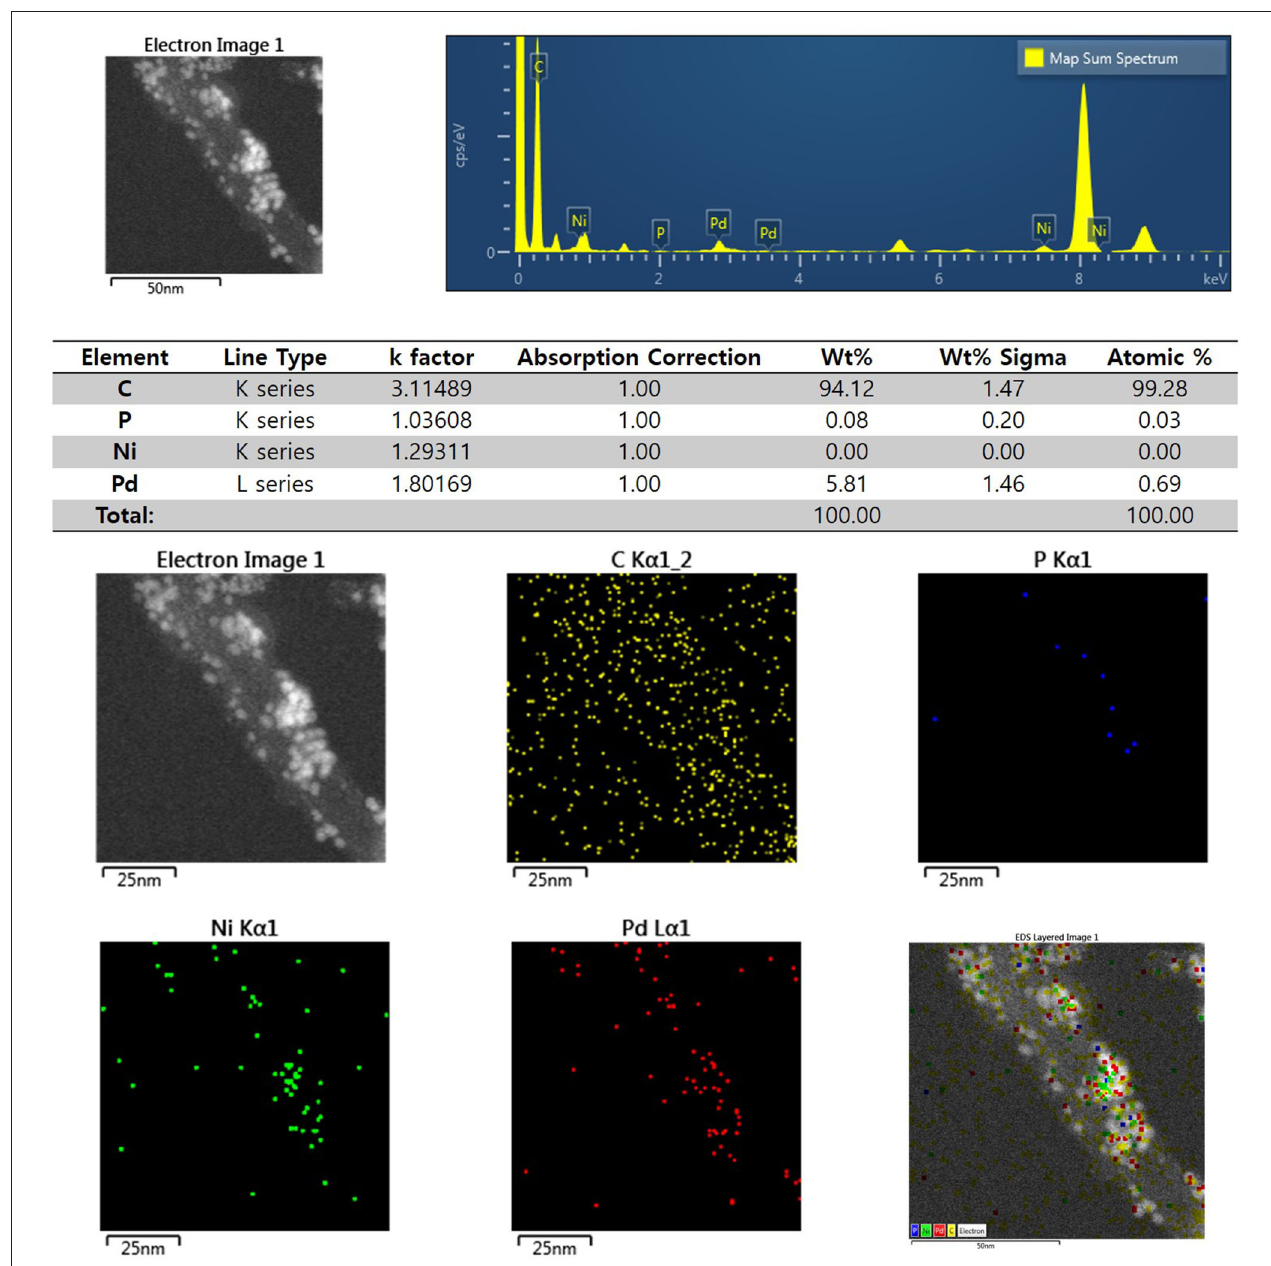
FIGURE 6 | EDS elemental analysis results and elemental mapping images of Ni-Pd/MWCNT